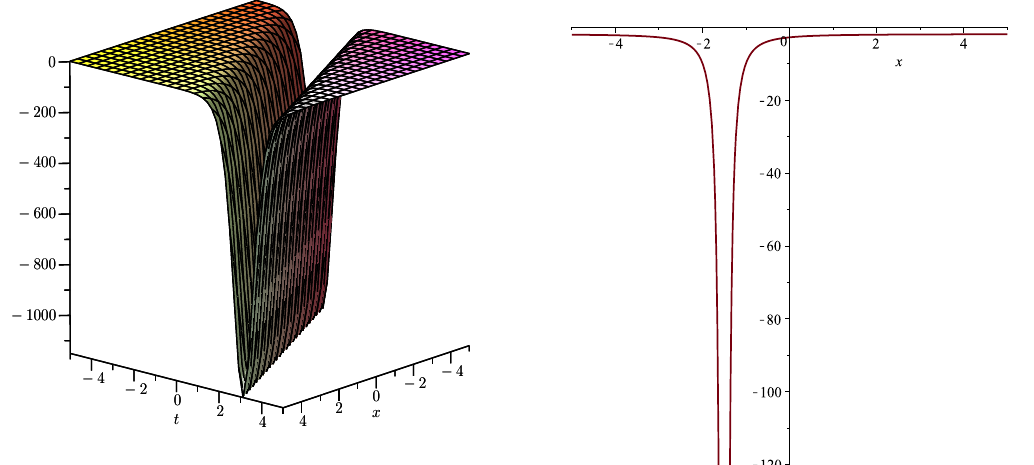
Figure 4. ( left ) 3D representation of solution (32) for ν = 2, κ = 0.5, ω = 1, ρ = ξ 0 = 1.5 and singular